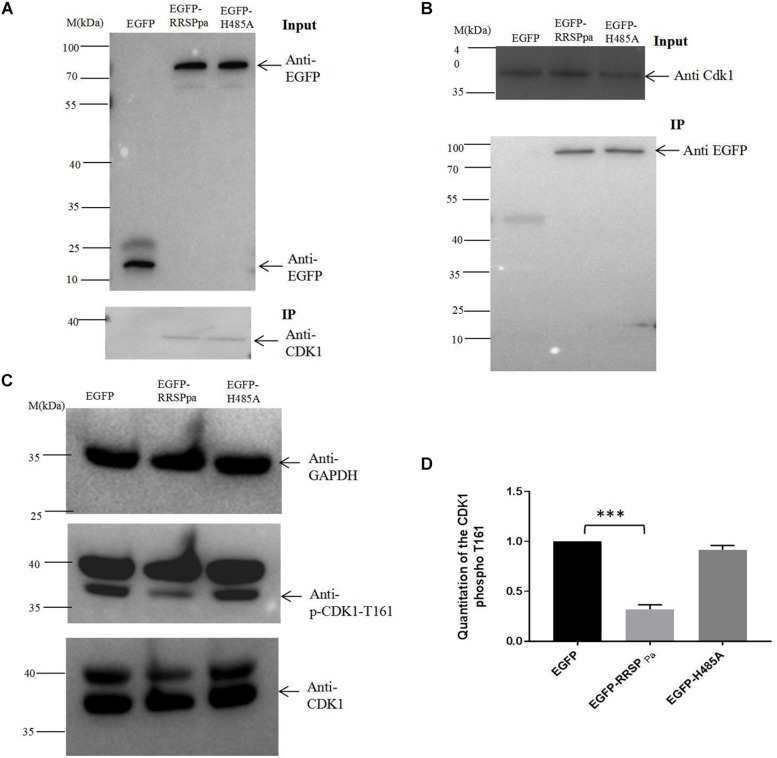
Interaction of RRSPPa with CDK1 by pull-down assays and the inhibition of CDK1 activity. (A) HeLa cells were transfected with pEGFP, pEGFP-RRSPPa, and pEGFP-H485A. The top panel shows the expression levels of EGFP, EGFP-RRSPPa, and EGFP-H485A in HeLa cells. The bottom panel shows the pull-down results. HeLa cell lysate was incubated with GFP-conjugated magnetic beads; immunoprecipitation was then conducted by blotting with anti-EGFP or anti-CDK1 antibodies. (B) HeLa cells were cotransfected with CDK1-Flag and EGFP, EGFP-RRSPPa, or EGFP-H485A, respectively. The top panel shows the expression levels of CDK1. The bottom panel shows the pull-down results. HeLa cell lysates were incubated with Flag-conjugated magnetic beads; immunoprecipitation was conducted by blotting with anti-CDK1 or anti-GFP antibody. (C) HeLa cells were transfected with different plasmids, cell lysates were prepared and the levels of CDK1, CDK1 phospho T161, GAPDH were detected by Western blot analysis. The experiments were repeated three times and the representative pictures were shown. (D) Quantitation of the intensity of the CDK1 phospho T161 protein bands in C. t-test was used for statistical analysis. ***P < 0.001.